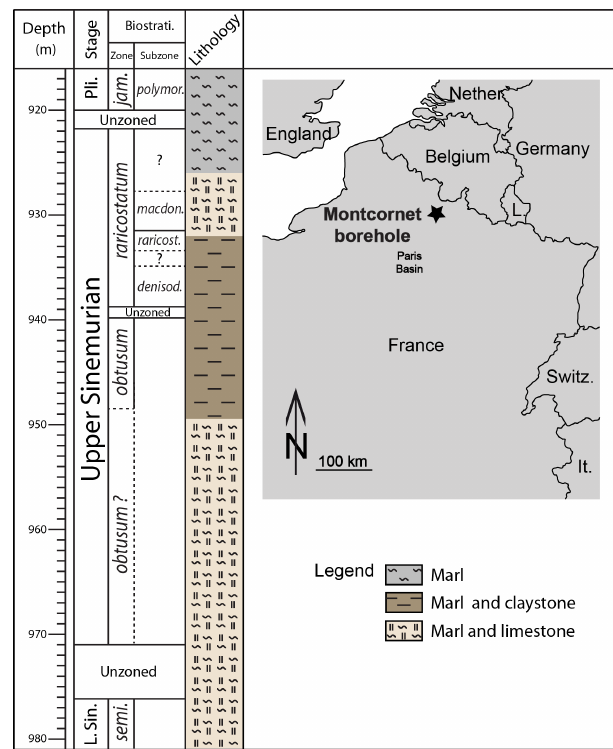
Figure 3. Location map of the Montcornet borehole, showing the simplified lithology and biostratigraphy of the upper Sine- murian (from Fauconnier, 1995; Yang et al., 1996). Abbreviations: densinod. – densinodulum , jam. – jamesoni , L. Sin – lower Sine- murian, macdonn . – macdonnelli , Pli. – Pliensbachian, polymor . – polymorphus , raricost. – raricostatum , semi. – semicostatum .